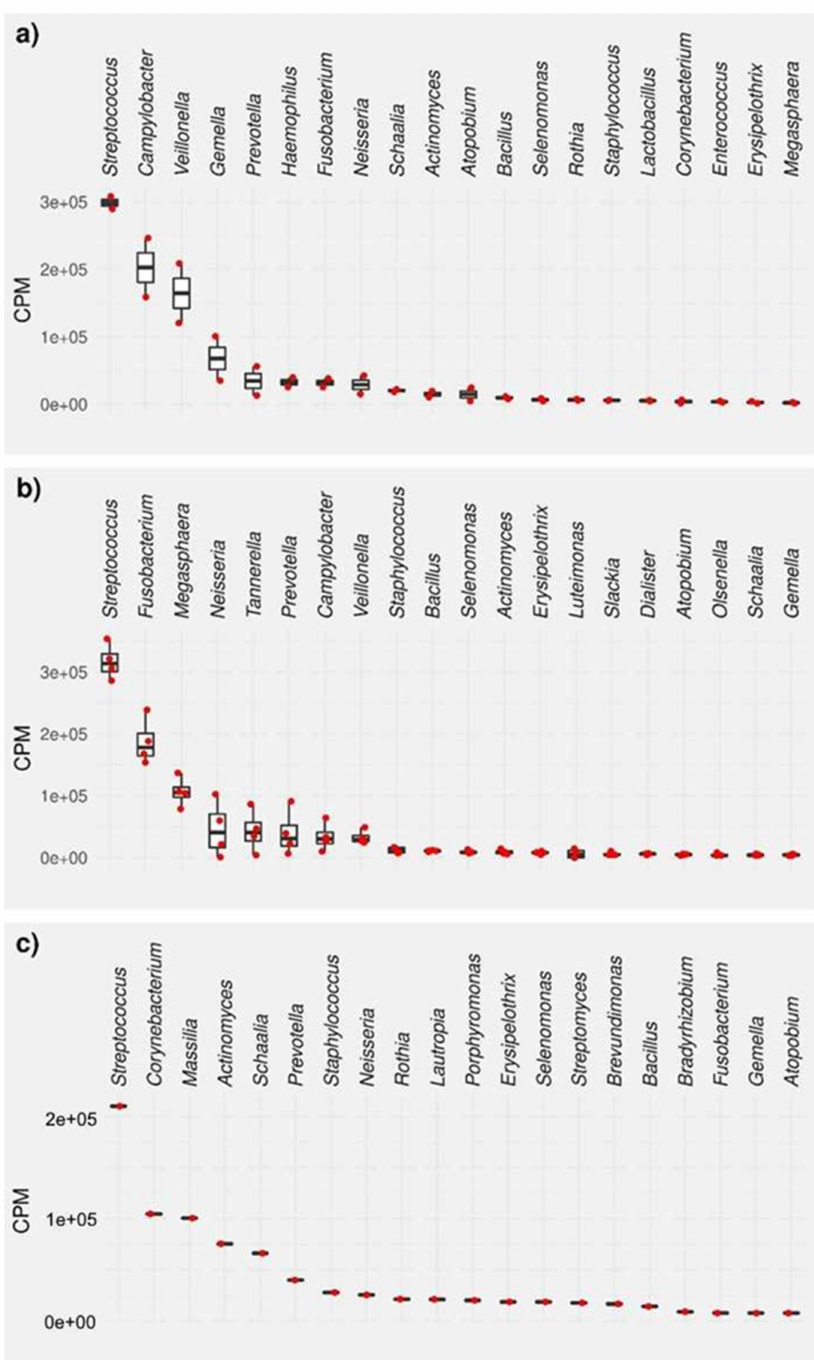
Figure 3. Top 20 most abundant bacterial genera, presented as CPM, for ( a ) bacteria found in saliva, ( b ) bacteria harvested from native biofilms grown on uncoated substrates, and ( c ) bacteria harvested from biofilms grown on uncoated substrates to which the disinfectant chlorhexidine digluconate ( CHX ) had been